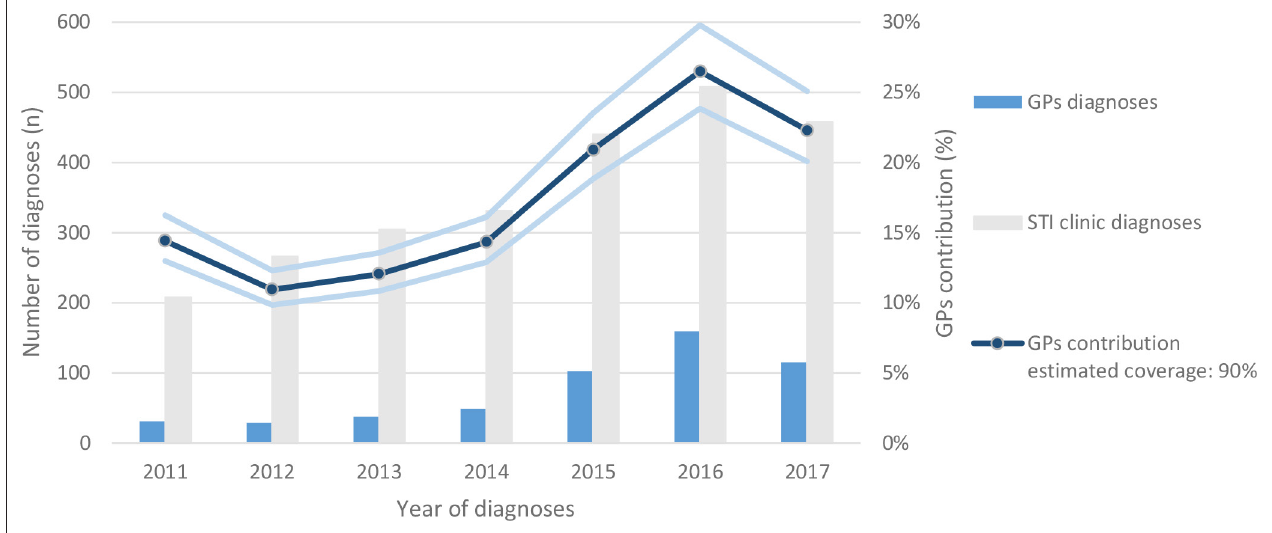
Figure 3 GPs and STI clinic syphilis diagnoses in Amsterdam. The number of syphilis diagnoses in Amsterdam between 2011 and 2017, shown for GPs and STI clinic. GPs’ contribution based on the extrapolated estimated 90% coverage of all GPs laboratory data in Amsterdam, with 80% and 100% coverage estimates as levels of uncertainty. STI = Sexually transmitted